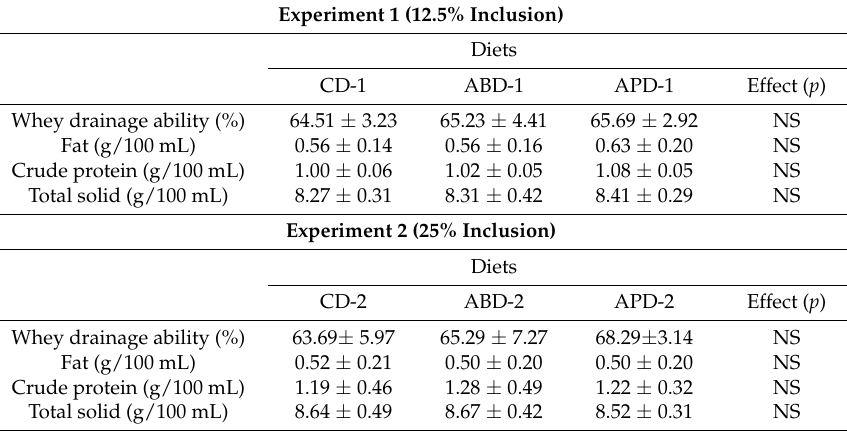
Table 5. Whey drainage ability (%) of milk and whey composition (fat, crude protein and total solid) for direct acidification from Murciano-Granadina goats fed on diets containing or not containing artichoke by-products (plant and outer bracts) in Experiment 1 (12.5% inclusion) and Experiment 2 (25% inclusion).